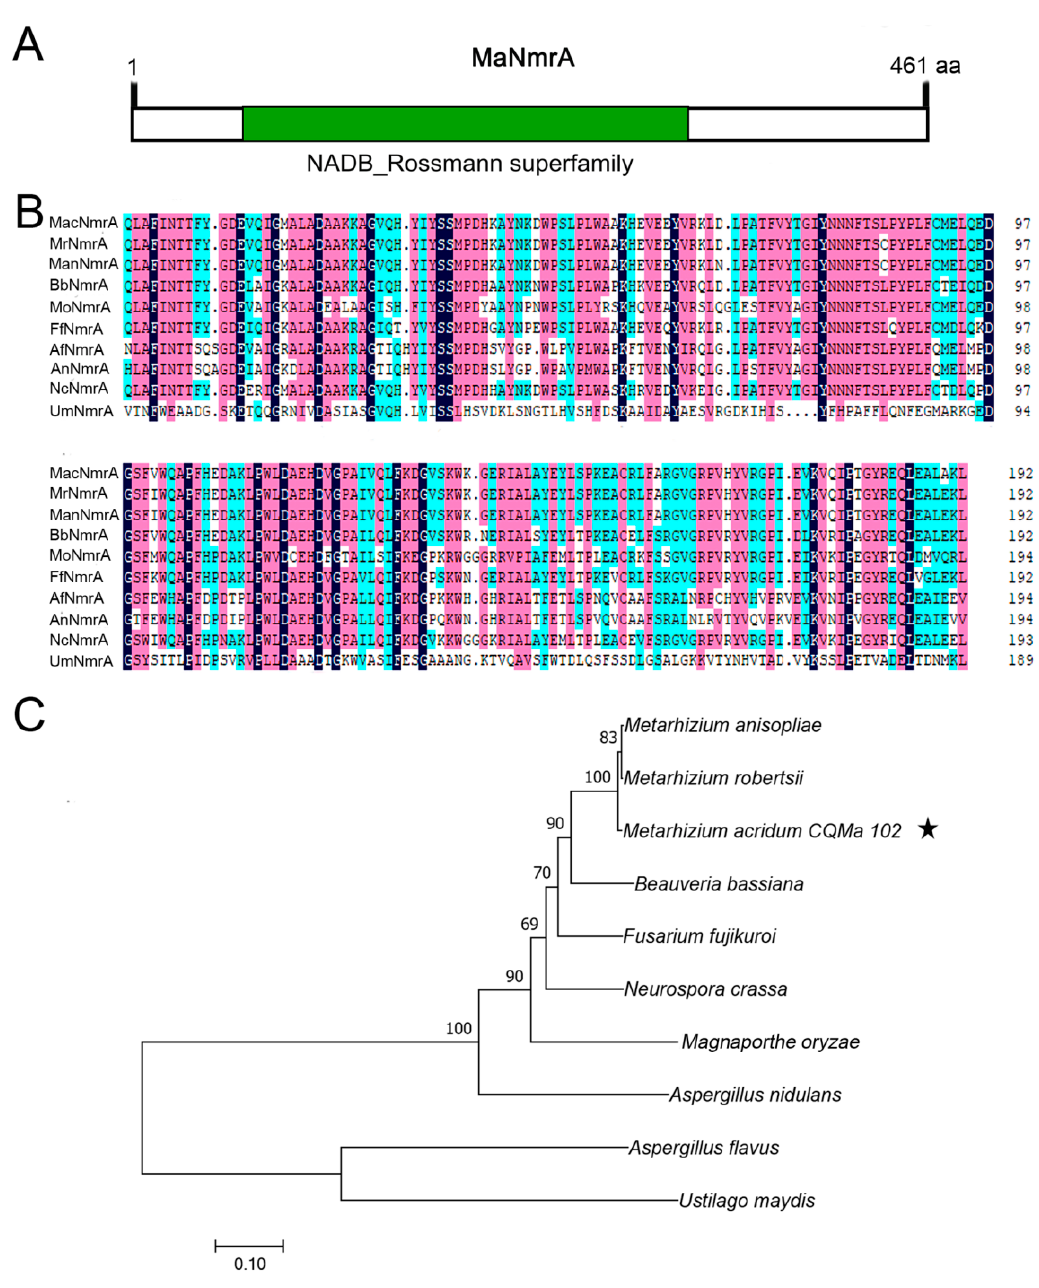
Figure 1. Conserved domain and phylogenetic analysis of MaNmrA. ( A ) Analysis of conserved domain in MaNmrA through SMART. ( B ) Multiple sequence alignments of the NAD or NADP binding domain among NmrA homologues. Mac , Metarhizium acridum (XP_007807089.1, MAC_00749). Mr , Metarhizium robberstii (XP_007825607.1). Man , Metarhizium anisopliae (KFG78248.1). Bb , Beauveria bassiana (XP_008599776.1). Mo , Magnaporthe oryzae (XP_003715776.1). Ff , Fusarium fujikuroi (CAA75863.1) . Af , Aspergillus flavus (XP_002382762.1). An , Aspergillus nidulans (AAC39442.1). Nc , Neurospora crassa (XP_961314.3). Um , Ustilago maydis (XP_011390347.1). ( C ) Phylogenetic tree analysis of MaNmrA and its homologous proteins. The pentastar indicated MaNmrA